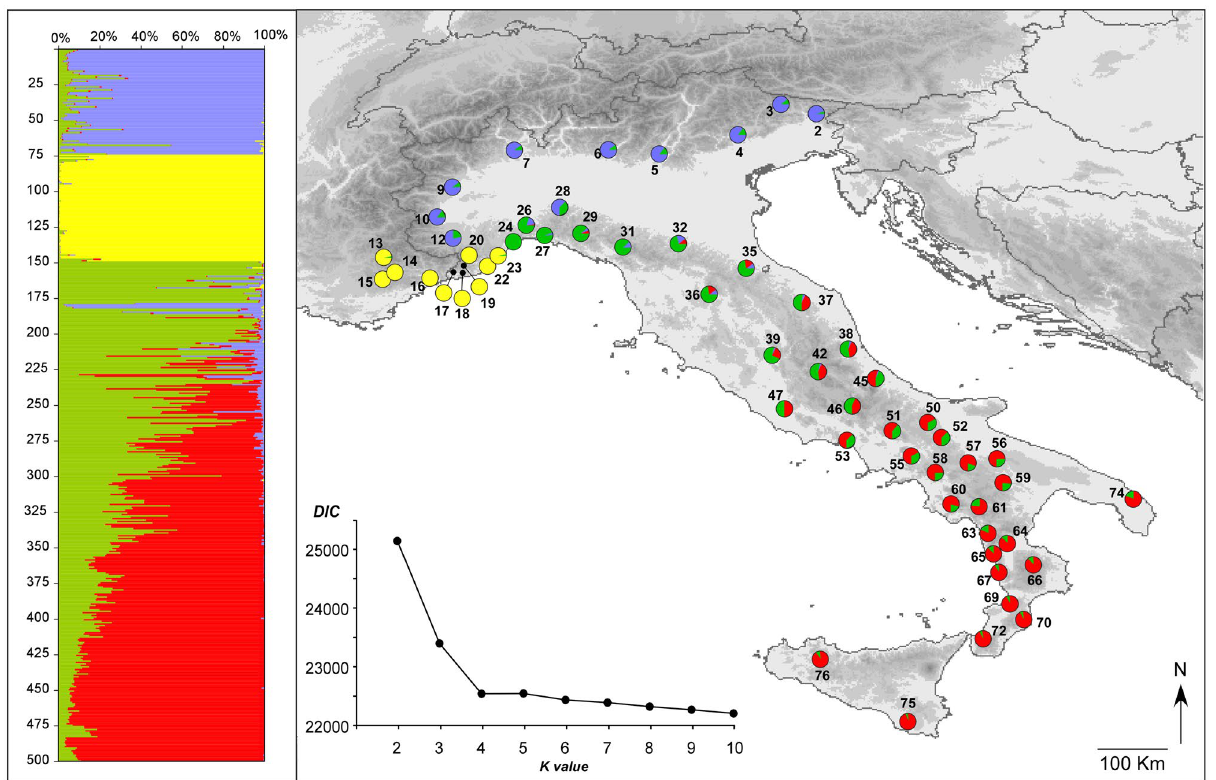
Figure 3. Genetic structure of the Italian Bufo bufo populations, as inferred by the Bayesian clustering analysis implemented in TESS based on eight microsatellite loci. The bar plot on the left shows the admixture proportions of each individual for the four genetic clusters identified; the pie diagrams on the maps show the frequency of each cluster within the studied populations. Populations are numbered as in Table 1. The line chart shows values of the deviance information criterion (DIC) statistics estimated for models with the number of genetic clusters (K) ranging from 2 to 10. The map was drawn using the software Canvas 11 (ACD Systems of America,